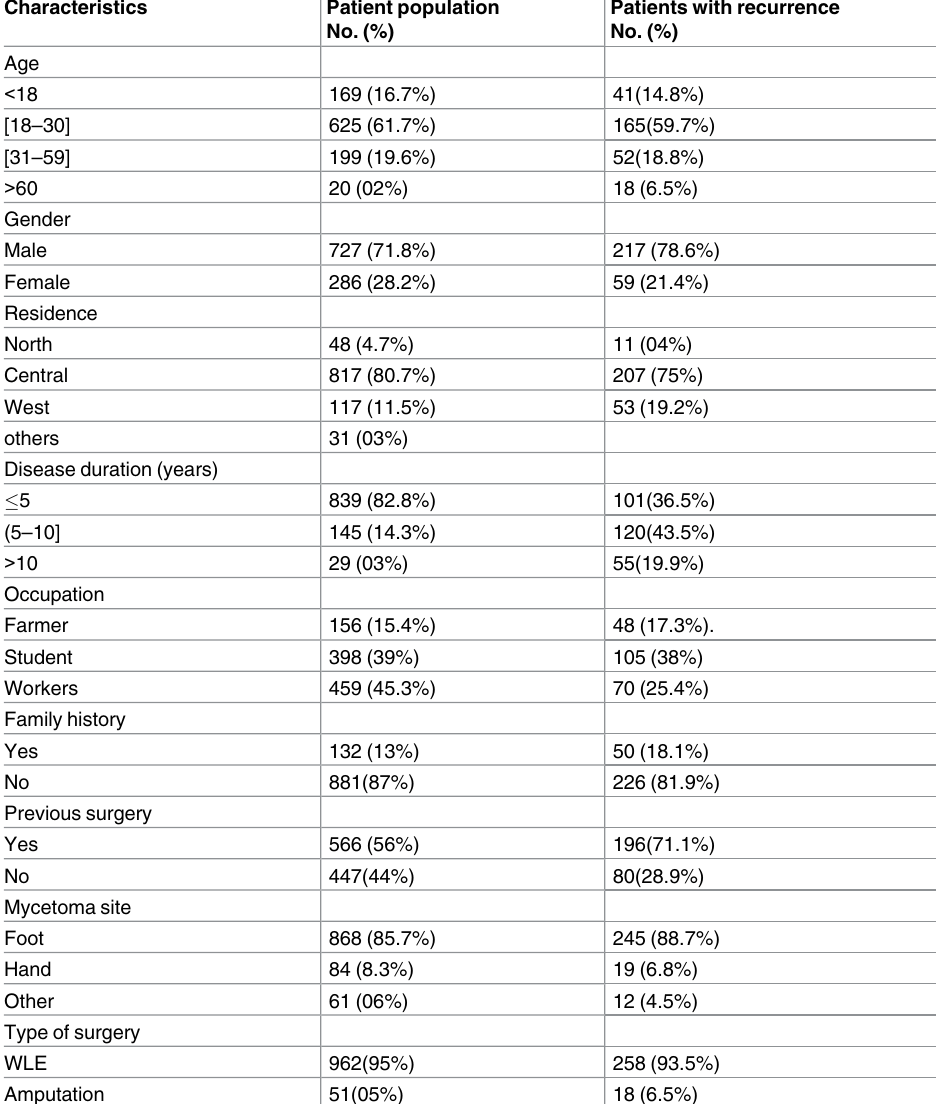
Table 1. The patients’ population